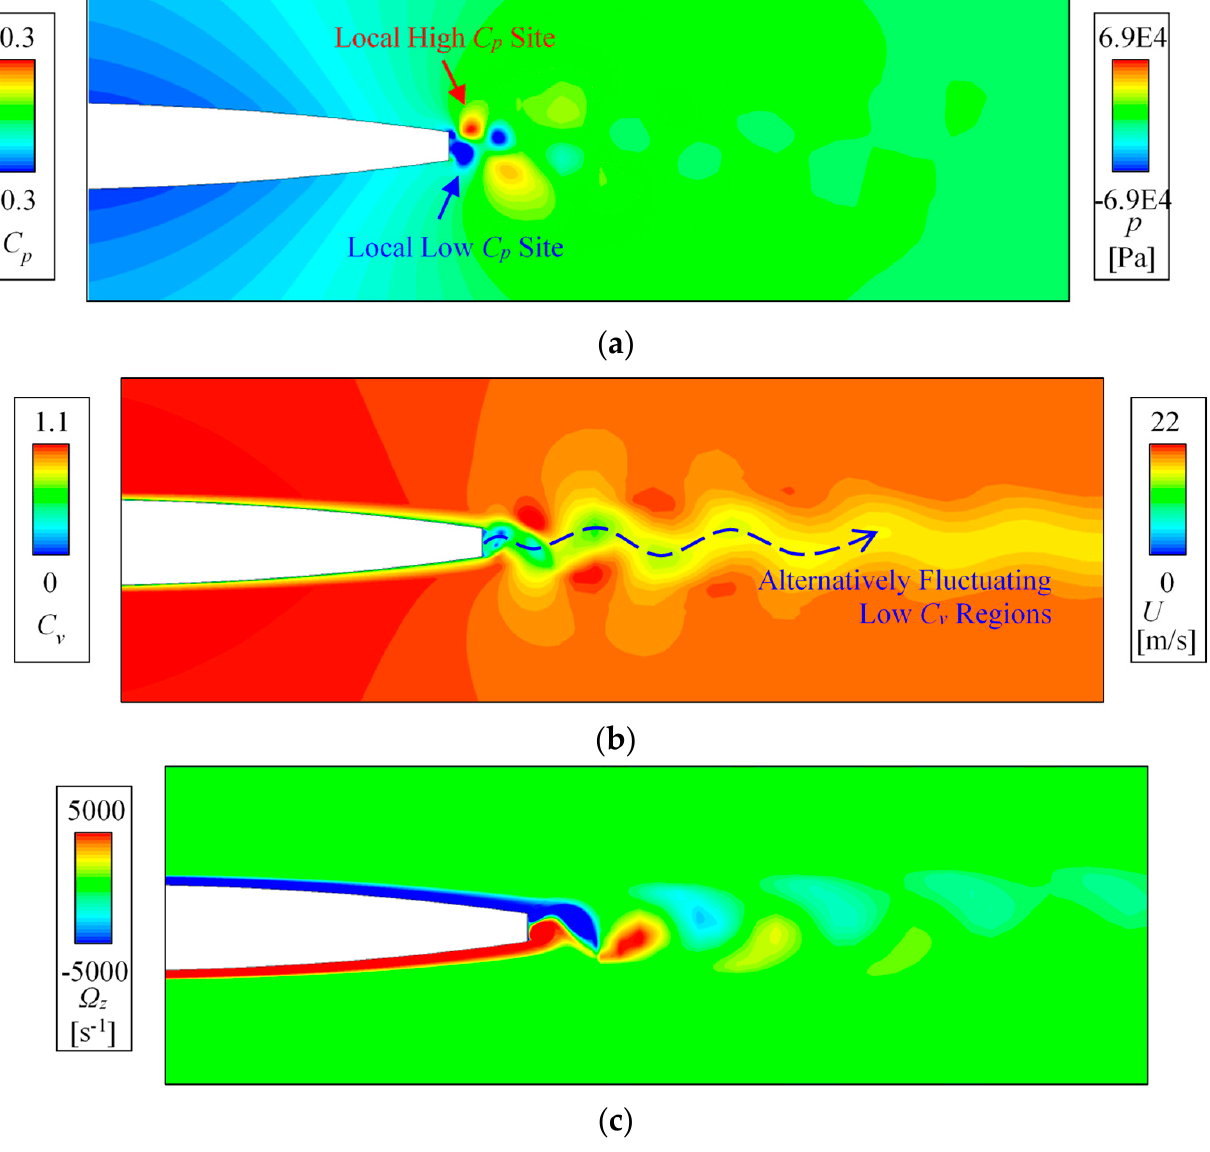
Figure 7. Flow patterns of trailing-edge vortex shedding of hydrofoil. ( a ) Pressure coefficient C p . ( b ) Velocity coefficient C v . ( c ) Vorticity perpendicular to the x-y plane of Ω z .